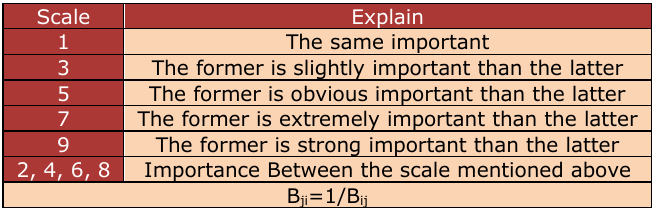
Table 2 . Judgment matrix